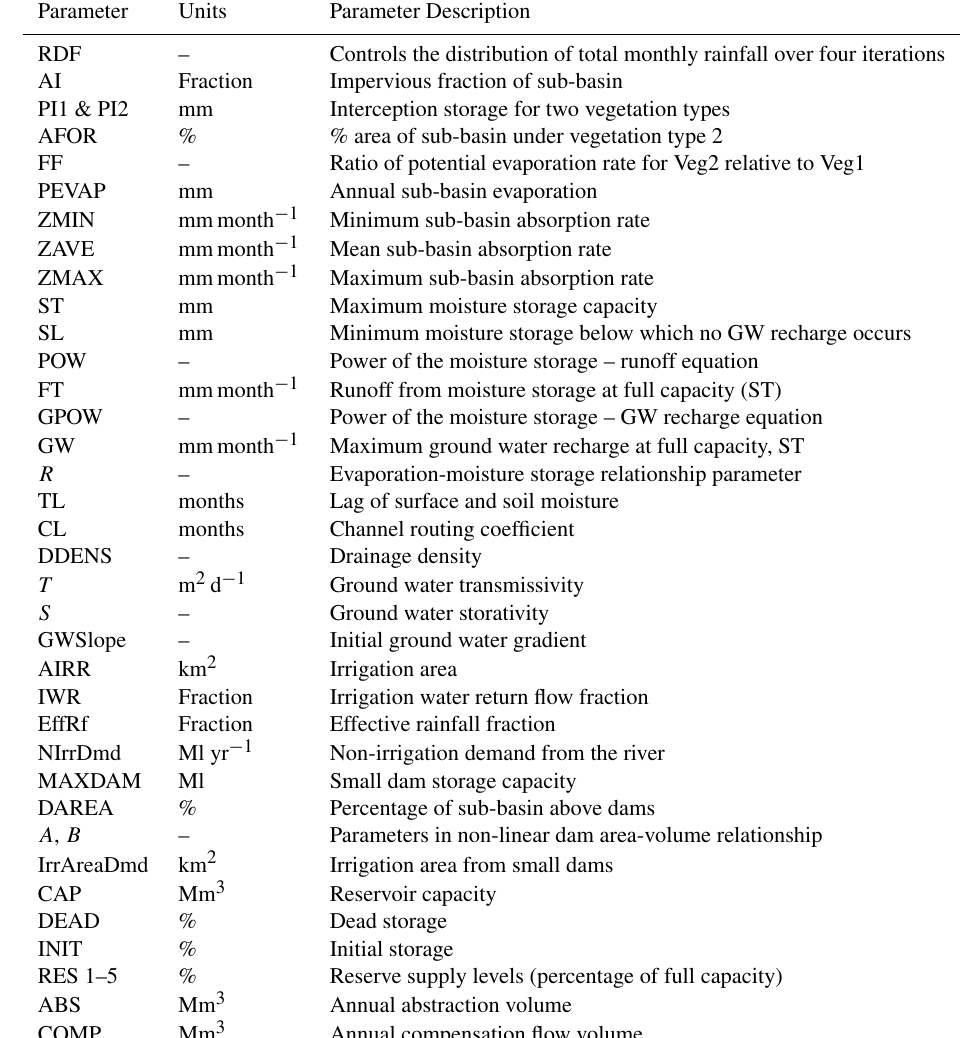
Table 1. A list of the parameters of the Pitman model including those of the reservoir water balance model (Hughes et al., 2006).